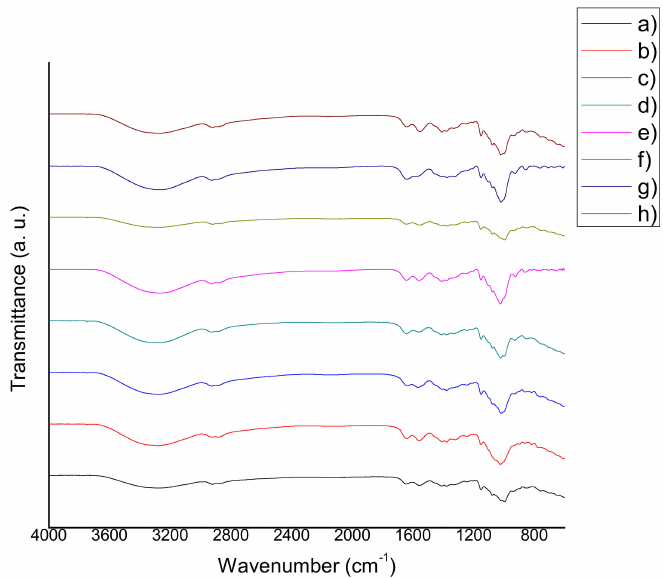
Figure 4. FTIR spectra of ( a ) QS2 vs. ( b ) QSA5; ( c ) QSAm5; ( d ) QSB5; ( e ) QSG5; ( f ) QSO5; ( g ) QSP5; and ( h )